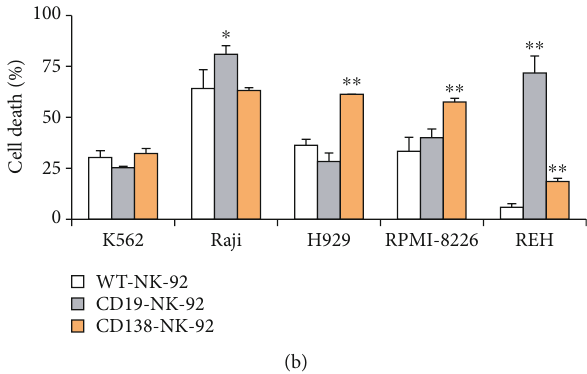
Figure 4: Selective cytotoxicity of CD19-NK-92 and CD138-NK-92 cells toward various hematologic cancer cells. (a) Human CML-derived K562, BL-derived Raji, MM-derived H929 and RPMI-8226 cells, and ALL-derived REH were labeled with PKH67 dye; incubated with WT-NK-92, CD19-NK-92, or CD138-NK-92 cells at the E : T ratio of 1 :5 for 4h; and stained with Annexin V-PE and 7-AAD. Representative dot plots of Annexin V-PE versus 7-AAD in PKH67-labeled cells were shown. (b) Percentage of total cancer cell death was plotted. Data are mean ± s : d : ( n = 3 ). ∗ p < 0 : 05 and ∗∗ p < 0 : 01 versus WT-NK-92 cells; two-sided Student ’ s t